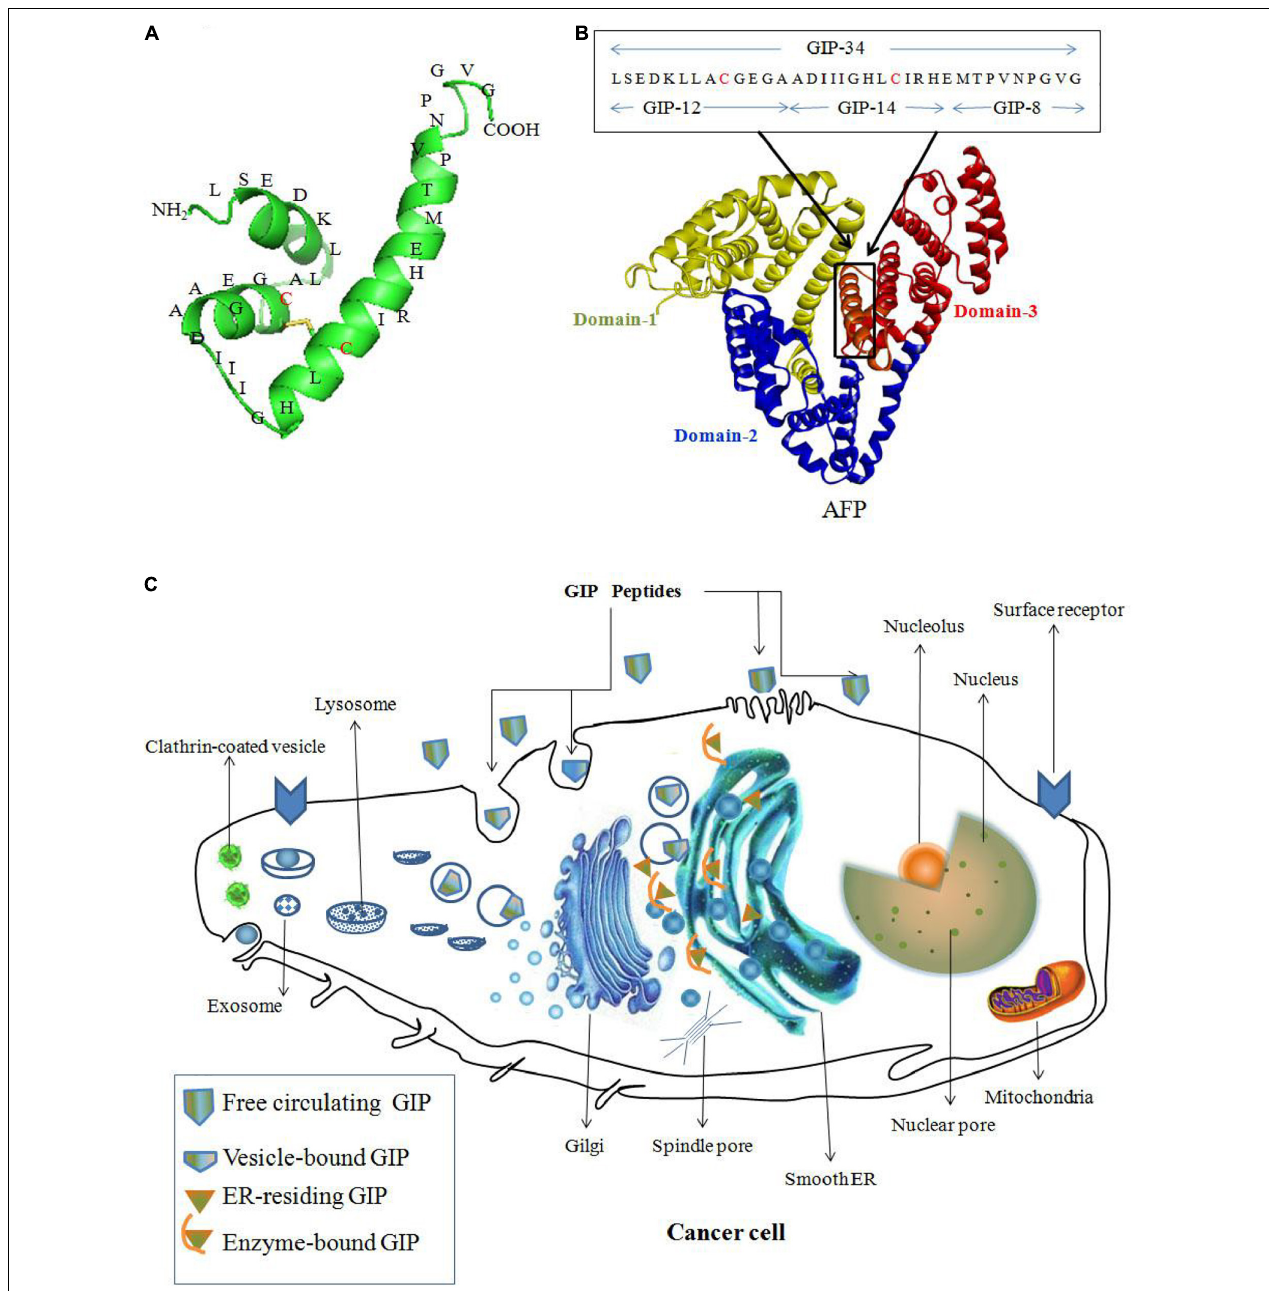
FIGURE 4 | Peptide AIFs (GIP) derived from AFP domain-3 are taken up by cancer cells and prevent AFP-induced malignant functions. (A) Amino acid sequence of GIP-34. (B) Amino acid sequence of GIP analogs (GIP-8, 12, 14 and 34) derived from the AFP domain-3 sequence (Mizejewski et al., 2010). (C) The anticancer mechanism of GIP. GIP gains cell entry by: (1) direct cell membrane penetration; (2) channel formation; and/or (3) pore formation into the cell cytoplasm, and the cytoplasmic GIP target the smooth endoplasmic reticulum (ER) surrounding the nucleus and influence enzyme activity during the growth and metastasis of